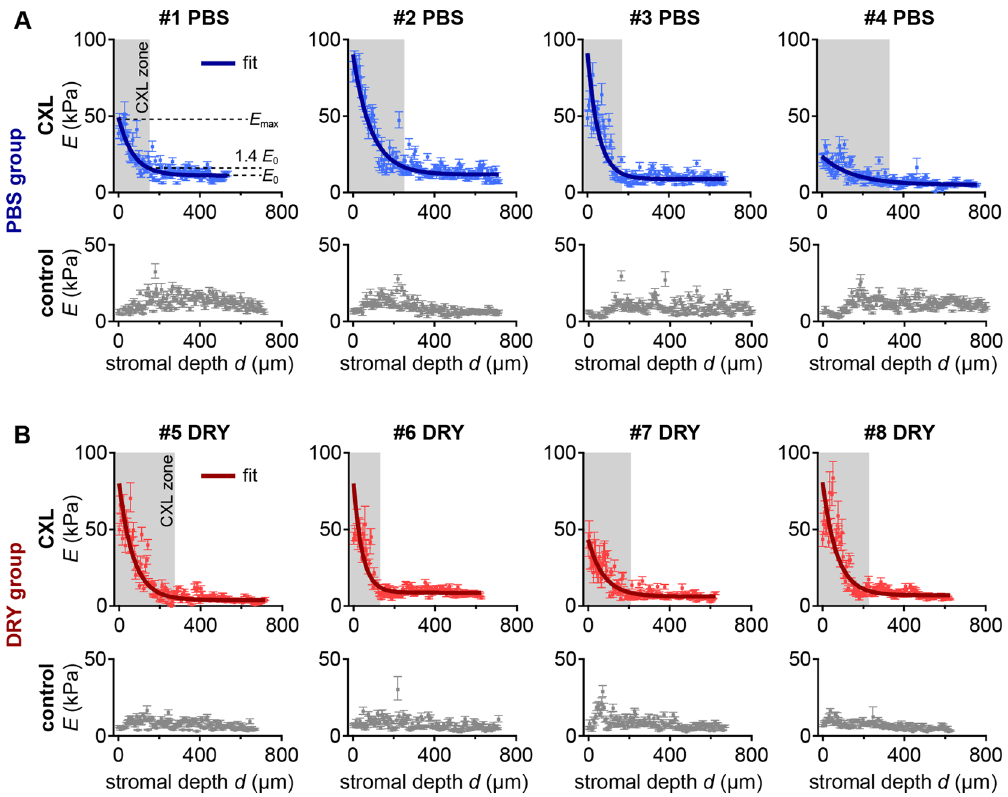
Figure 3. YM profiles across CXL and control corneas. A) Corneas dissected in PBS. B) Corneas dissected without any fluid (‘‘DRY’’). An increasing YM toward the corneal surface ( d =0) was found in the CXL samples. An exponential function (Equation 2) was fit to the YM profiles of CXL samples, giving E max (YM at the corneal surface) and E 0 (YM at the endothelial side). The CXL zone of effective cross-linking was defined as the zone where the YM of the fit exceeded 1.4 E 0 . Error bars: geometric standard error interval.